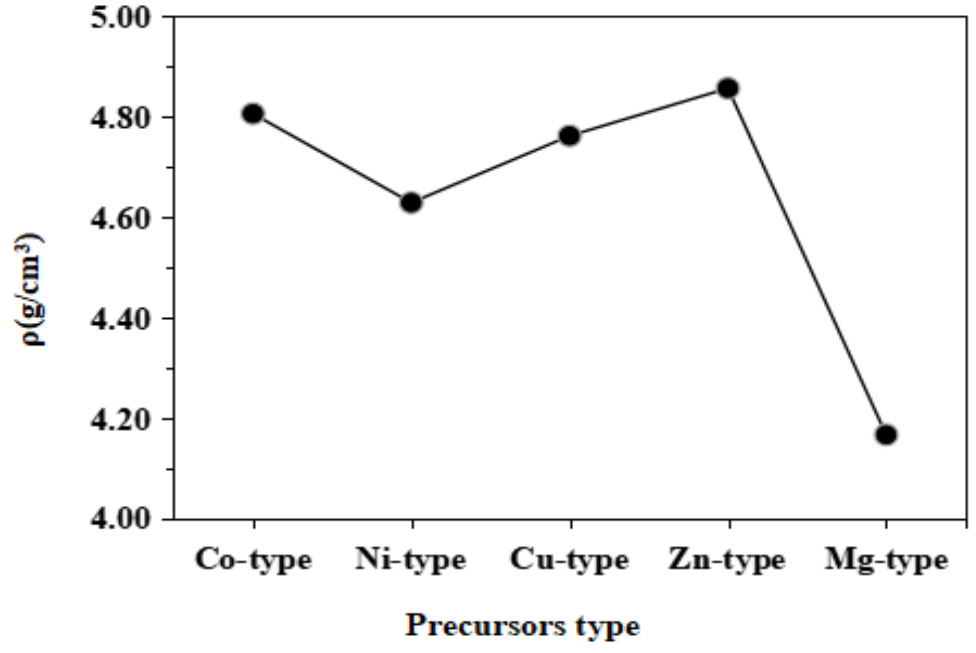
Figure 3. Density ( ρ ) of Sr 0.1 Ca 0.4 La 0.5 Fe 12 O 19 specimens with different